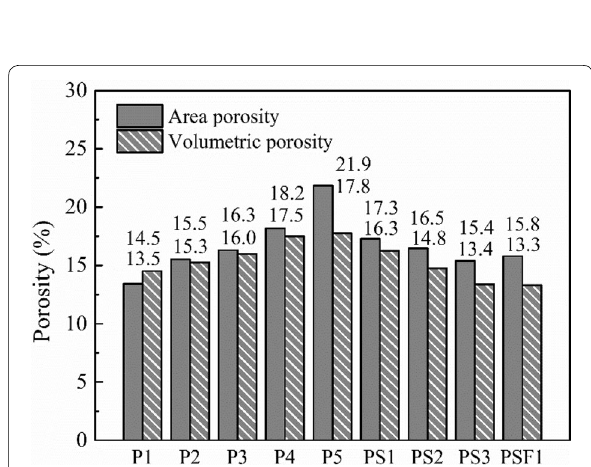
Fig. 6 Comparison of the area porosity and volumetric porosity of pervious concrete specimens.